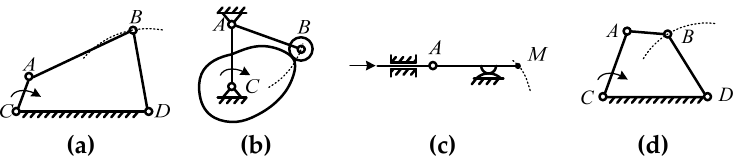
Figure 13. Curve track mechanisms. ( a ) Crank-rocker mechanism ( A , B , C , D : Hinge; B : Key point.); ( b ) disc cam mechanism ( A , B , C : Hinge; B : Key point.); ( c ) moving cam mechanism ( A : Hinge; M : Key point.); ( d ) double-rocker mechanism ( A , B , C , D : Hinge; B : Key